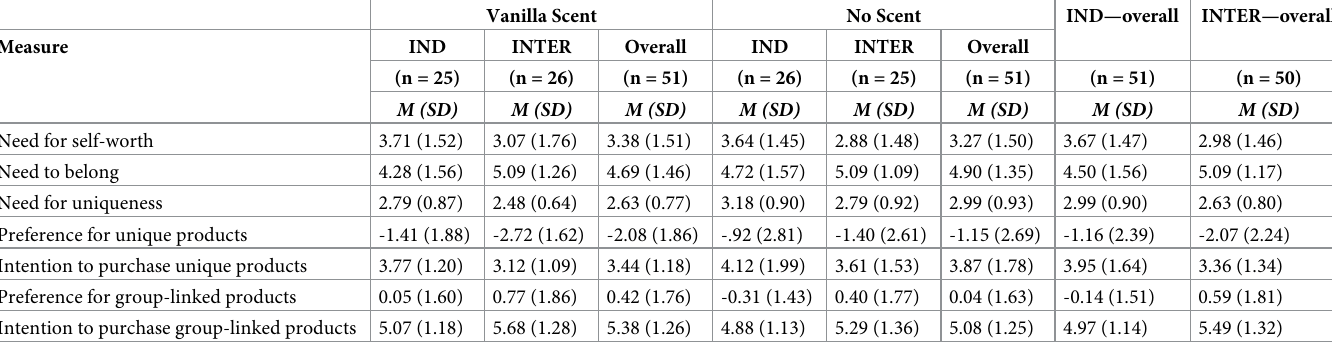
Table 4. Descriptive statistics for self-reports in Study 2. Vanilla Scent No Scent IND—overall